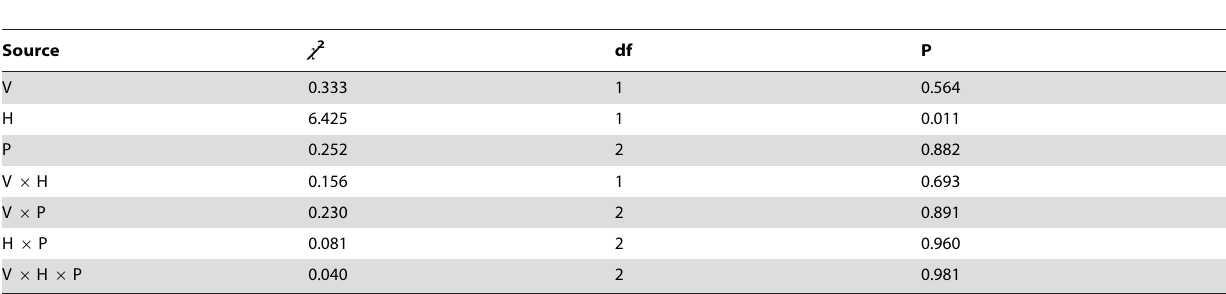
Table 3. Effects of water volume (V), water heterogeneity (H), and soil profile (P) on mean CV of the relative soil moisture.